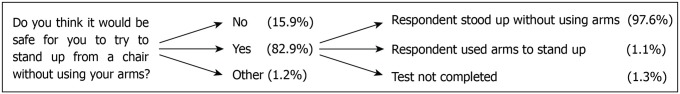
Sequence of questions and proportions of answers ascertaining tested mobility.